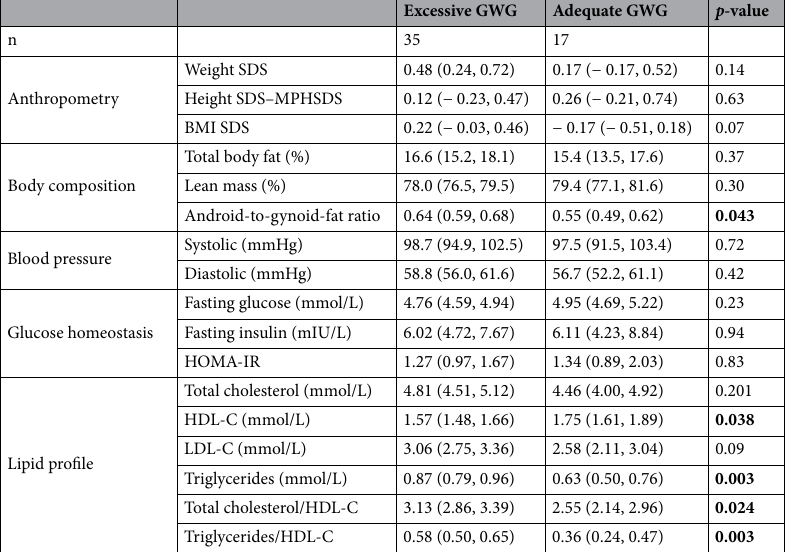
BMI at baseline (kg/m 2 ) 22.0 ±